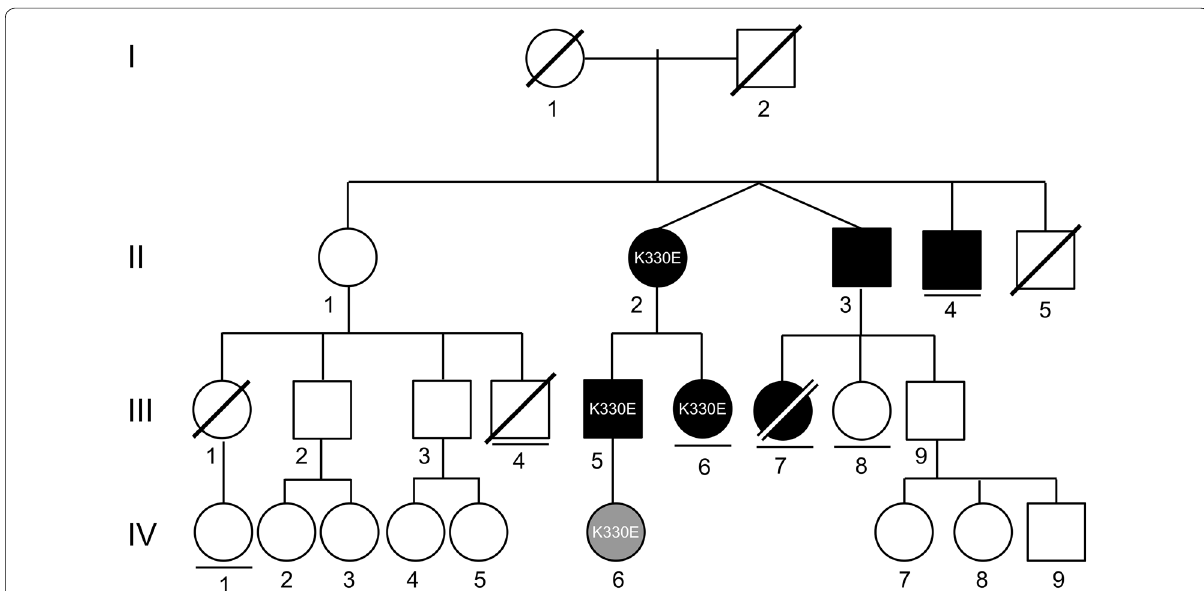
Fig. 1 Pedigree of a family with hereditary angioedema associated with a plasminogen mutation (HAE‑PLG). Symbol description: Circles indicate females, squares males. Black filled symbols indicate affected individuals, gray filled symbols mutation carriers without symptoms. A slash indicates a deceased individual. A horizontal line below a symbol indicates that the (adult) individual has no children. Roman numerals indicate generations, Arabic numerals individuals within a generation. “K330E” in circles or squares indicates individuals who were available for genotyping and showed the plasminogen mutation p.Lys330Glu mutation (K330E). The other affected individuals were so far not available for